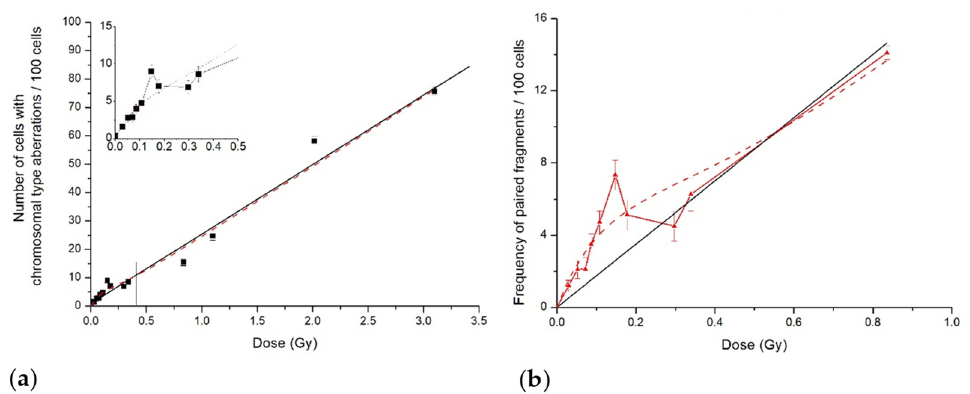
Figure 3. Cytogenetic effects in CHO-K1 cells induced by 14.5 MeV neutrons: ( a ) number of cells with aberrations of chromosome type; ( b ) frequency of paired fragments. Symbols are experimental data; solid lines are LQ model approximations, whereas dash line shows our fit to the data of the IR model.